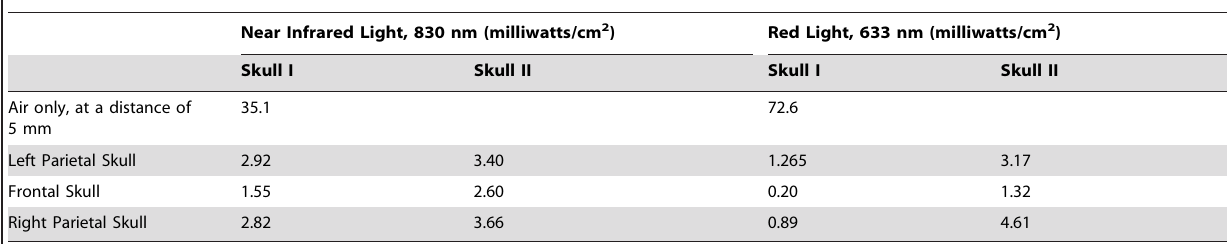
Table 1. Transmission of Near Infrared and Red Light through Cadaver Skulls in Coronal Sections.